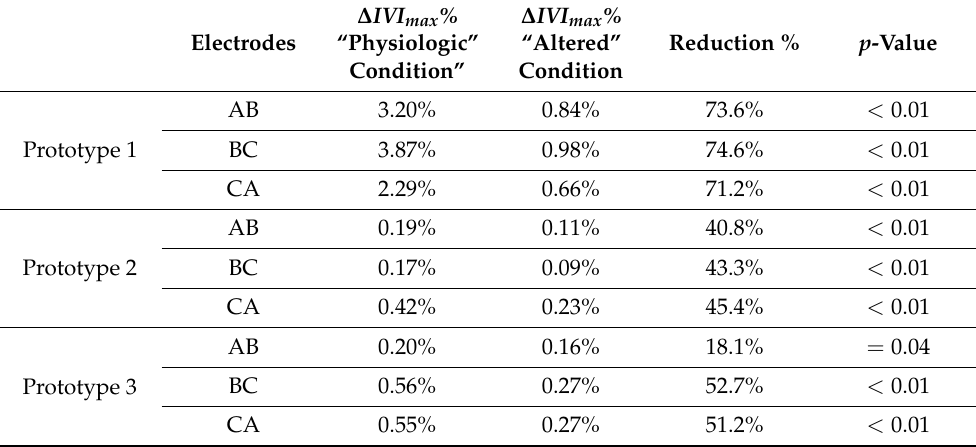
Table 3. Summary of ∆ IVI max % values obtained in both “physiologic” and “altered” working conditions in the three Prototypes, with the respective value of ∆ IVI max % reduction (given as %) when passing from “physiological” to “altered” working conditions. p -value obtained with Student’s t -test is